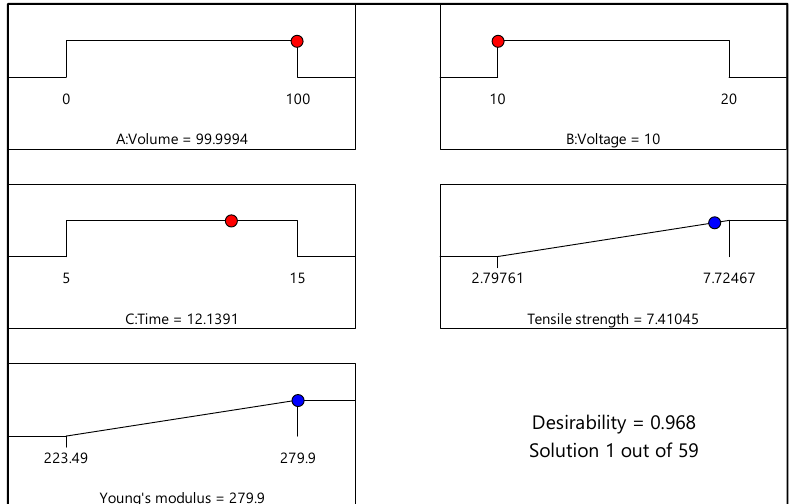
Figure 11. Ramp chart for statistically optimized factors and response for experimental design of 0% and 100% water.